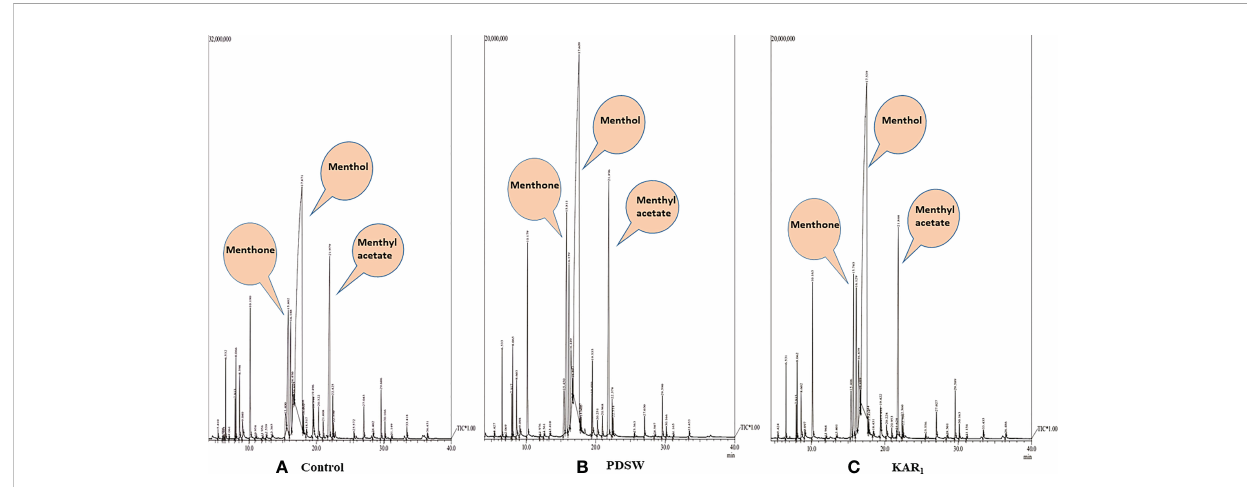
FIGURE 5 GC-MS chromatogram of essential oil of Mentha arvensis L. (A) Control, (B) 1:500 v/v of PDSW and (C) 10 -8 M of KAR 1 .